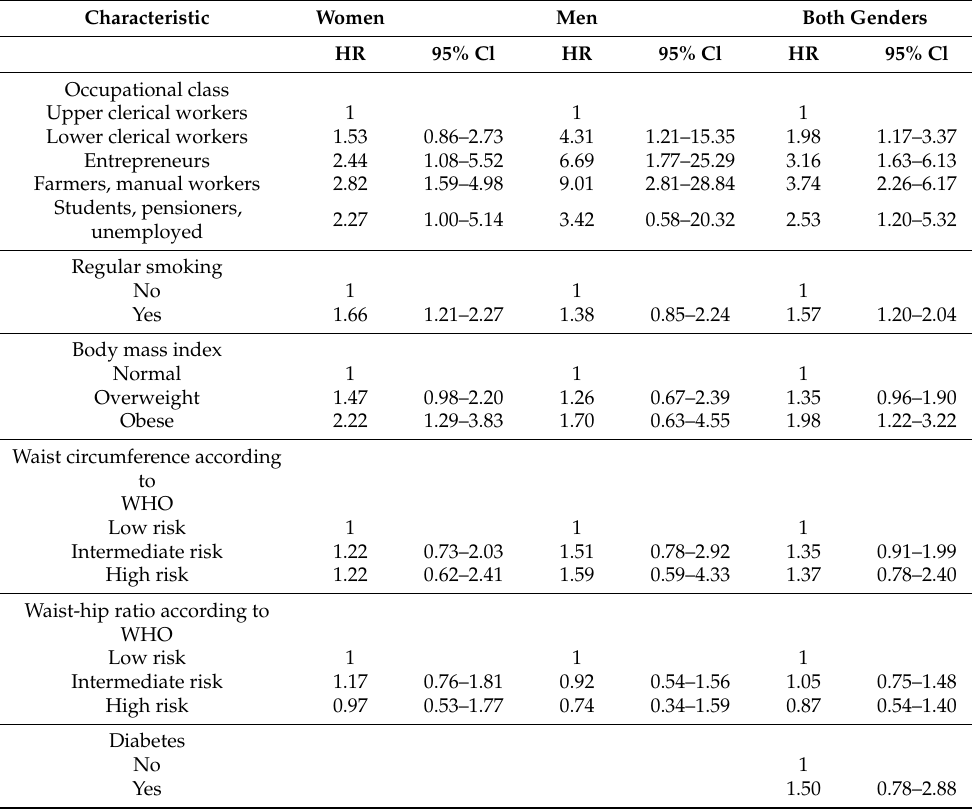
Table 3. Sex-specific hazard ratios (HR) with 95% confidence intervals (CI) of diagnosed carpal tunnel syndrome. Full model models for men, women and both